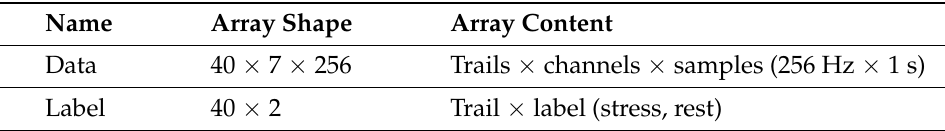
Table 1. A summary of Dataset Structure